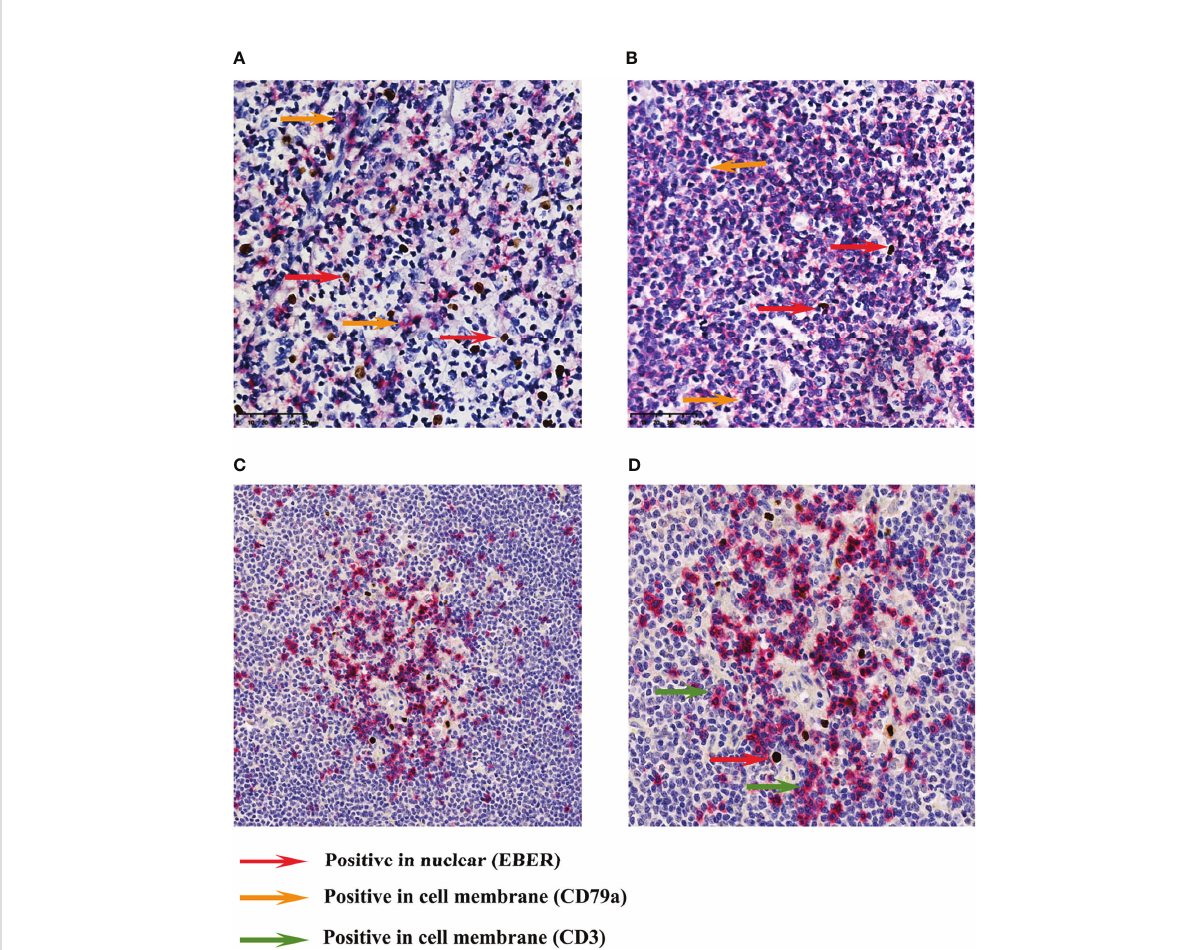
FIGURE 4 Immunohistochemical double-staining for EBER ISH and CD79a/CD3. A mixture of cell membrane-positive cells and nuclear-positive cells (A) (case 1). The cell membrane-positive cells were distributed in the tumor area, while most of the nuclear-positive cells were scattered in the inter-tumor area (B) (case 4). Most cases did not show membrane and nuclear positivity at the same time (magni fi cation: ×400). EBER and CD3 immunohistochemical double-label staining revealed that EBER-positive cells were mainly distributed in the area of CD3-positive T cells (C) (case 4). A small number of EBER-positive cells could be clearly classi fi ed as CD3-positive cells (D) (case 4). Images (C, D) were captured at ×200 and ×400 magni fi cation,